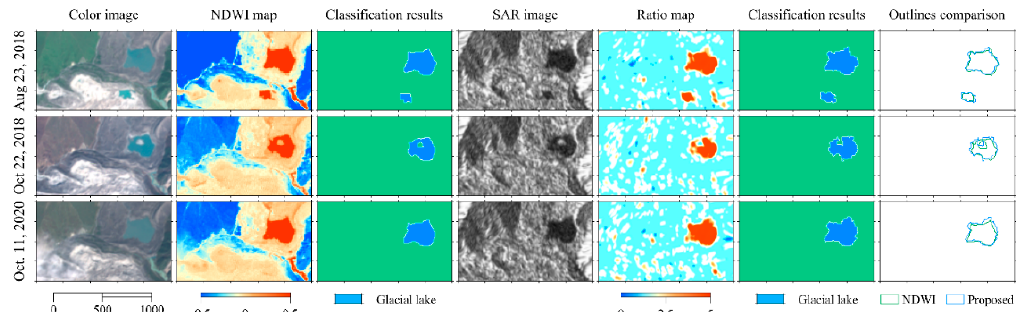
Figure 13. Comparison of glacial lake classification results between SAR images and optical images acquired on the same day. The first to third columns are the true color images, the NDWI color relief maps, and the classification results derived from NDWI maps. The fourth to sixth columns are the 8-bit SAR intensity maps, the ratio color relief maps, and the classified binary maps based on SAR images. The seventh column is the comparison of the glacial lake boundaries delineated by SAR image and optical image. Table 2. Comparison of the area of the XGL extracted from Sentinel-2 A/B optical images with that extracted from Sentinel-1 SAR image acquired on the same day.